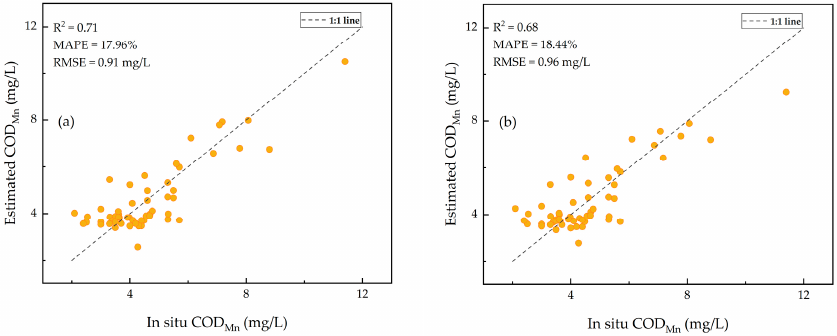
Figure 8. Performance evaluation of DO retrievals using the XGBoost for Sentinel-2 ( a ) and ZY1- 02D ( b ). For COD Mn retrieval models, SVR had the best performance for Sentinel-2 (R 2 = 0.71, MAPE = 17.96%, RMSE = 0.91 mg/L) and ZY1-02D (R 2 = 0.68, MAPE = 18.44%, RMSE = 0.96 mg/L) (Figure 9).